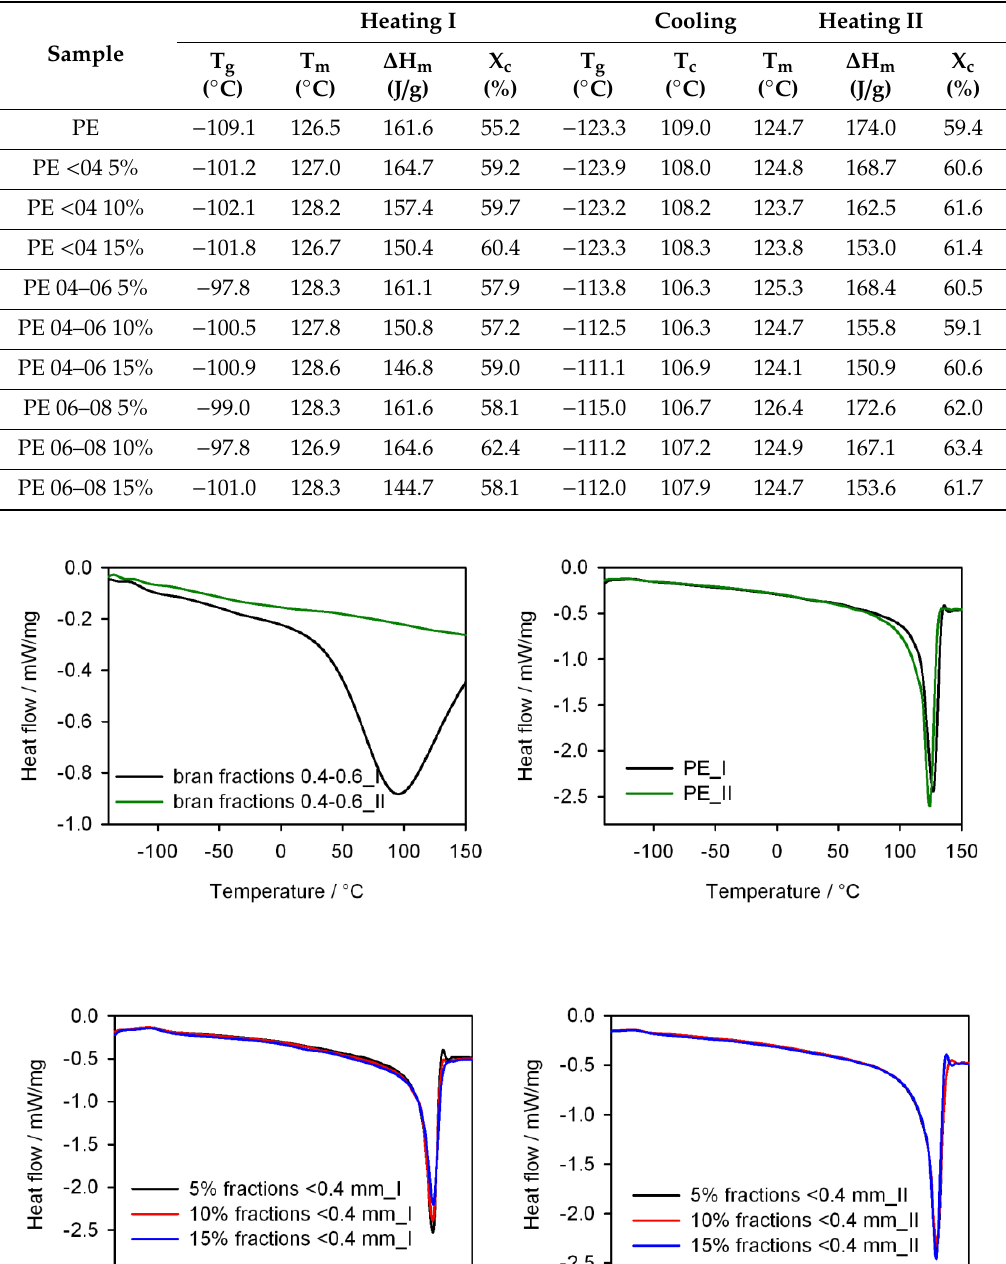
Table 2. Glass transition, crystallization and melting temperatures and degree of crystallinity of polyethylene and its composites with bran obtained on the basis of DSC tests.